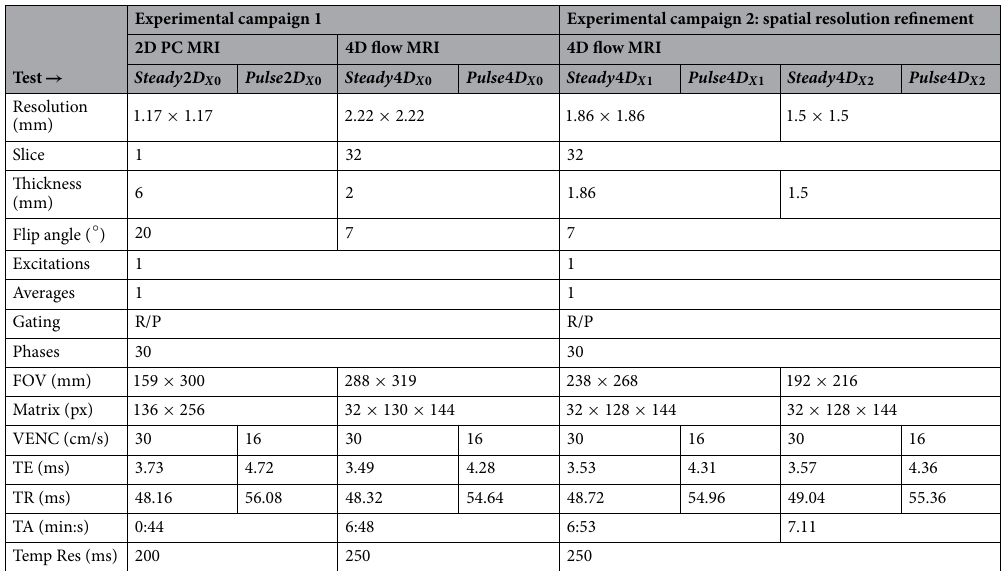
Table 1. Left: Standard 2D and 4D PC MRI experimental protocols. Right: Spatial resolution refinement 4D PC MRI protocol. X0 original data resolution, X1 data resolution refinement 1, X2 data resolution refinement 2. Resolution refers to z – y axes and matrix refers to the number of pixels along z , y , and x axis respectively; see Fig. 1b for axis reference. R/P retro/pulse, TE echo time, TR repetition time, TA acquisition time, Temp Res , temporal